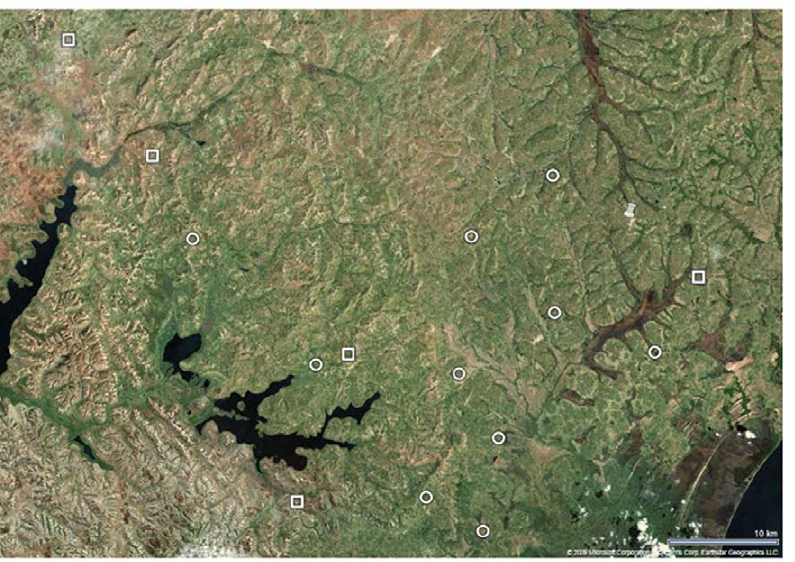
Figure 2. Map of cluster sites in Rakai, Uganda. Legend: Circles=Peer Health Worker Intervention Clinics (Arm A); Squares=Control Clinics (Arm B); Thumbtack=Central Clinic.